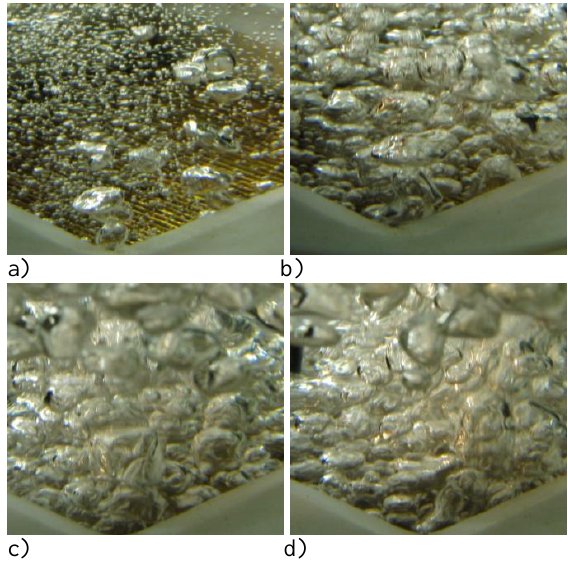
Fig. 5. Visualization observations of pool boiling of ethanol on microchannel surface MC-0.3-0.4-0.6. a) q = 21.9 kW/m 2 , b) q = 49.3 kW/m 2 , c) q = 88.2 kW/m 2 , d) q = 126.2 kW/m 2